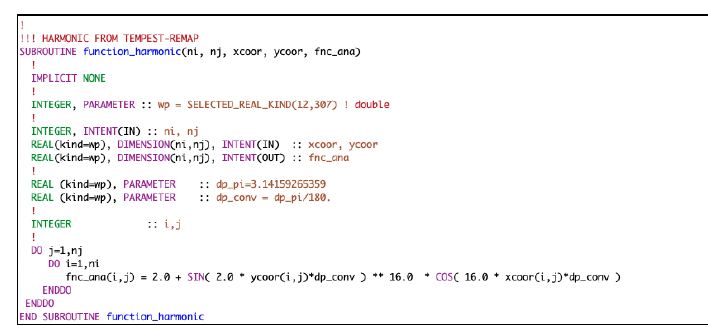
Figure A2. Fortran 90 code defining the harmonic analytical function.